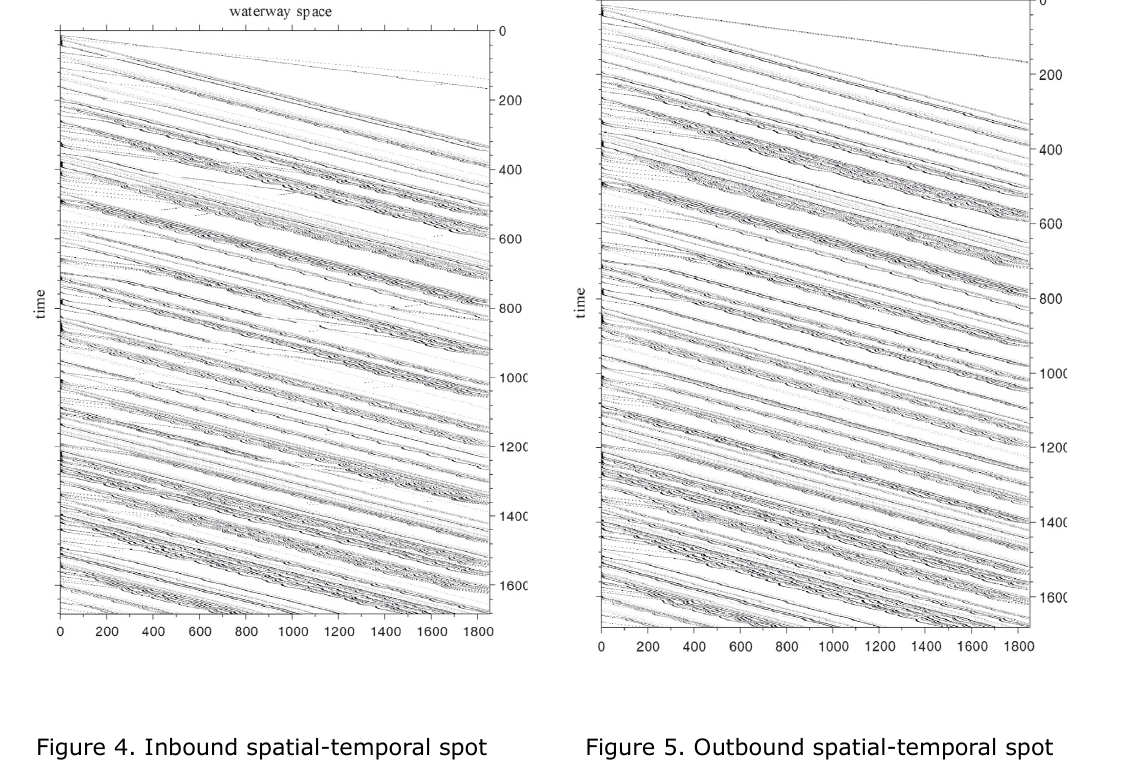
Figure 5. Outbound spatial-temporal spot diagram when prohibit changing